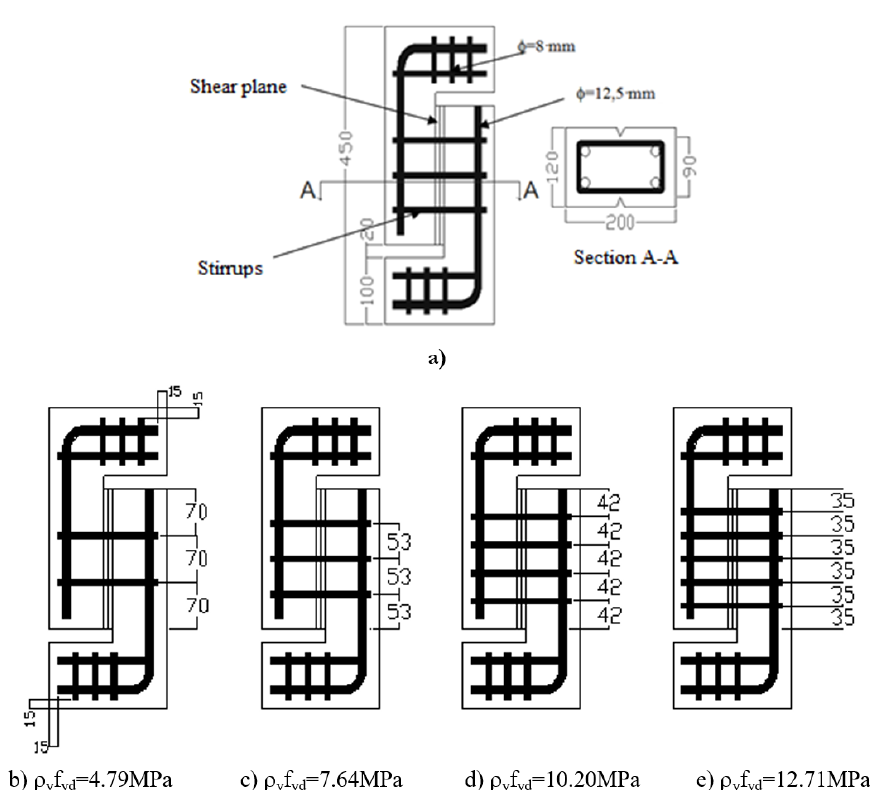
Figure 3. Transverse and auxiliary reinforcements on push-off specimens: a) specimen dimensions (mm); b), c) e d) series A, B, C, D and E and e) series A, B e